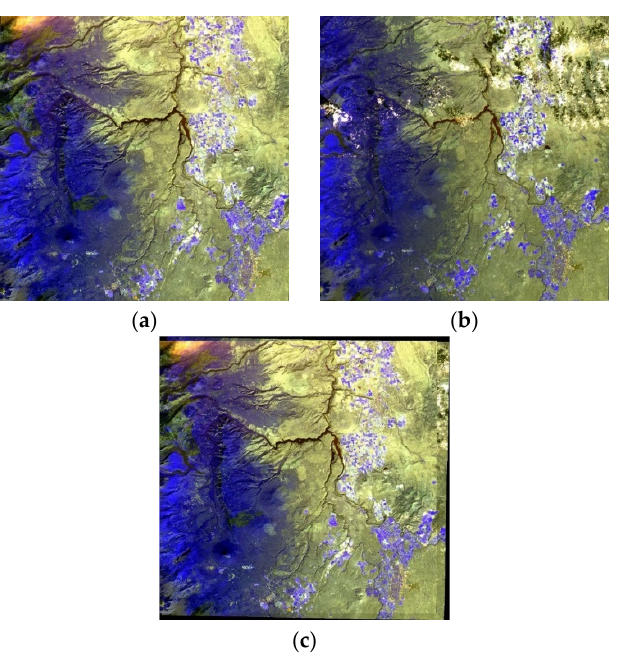
Figure 9. A GF-2 image pair: ( a ) Acquired on 19 February 2015; ( b ) acquired on 24 February 2015; ( c ) the stitched GF-2 image. Table 2. Comparison of the KNN-TAR and RANSAC algorithms for GF-2 images. Number of Pairs by Number of Pairs by Match Methods Time (ms) RMSE (Pixels) Rough Matching Fine Matching